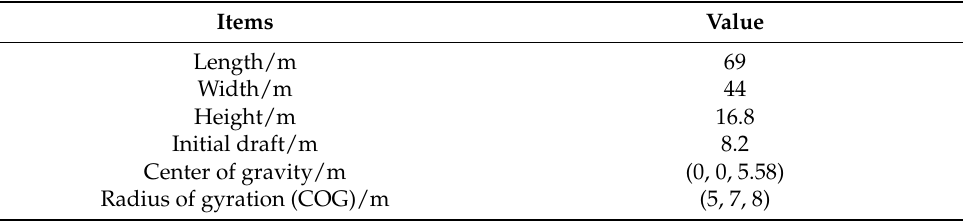
Figure 1. ( a ) Top view of the caisson; ( b ) Caisson model simulated in Ansys SpaceClaim. Table 1. Main parameters of caisson.